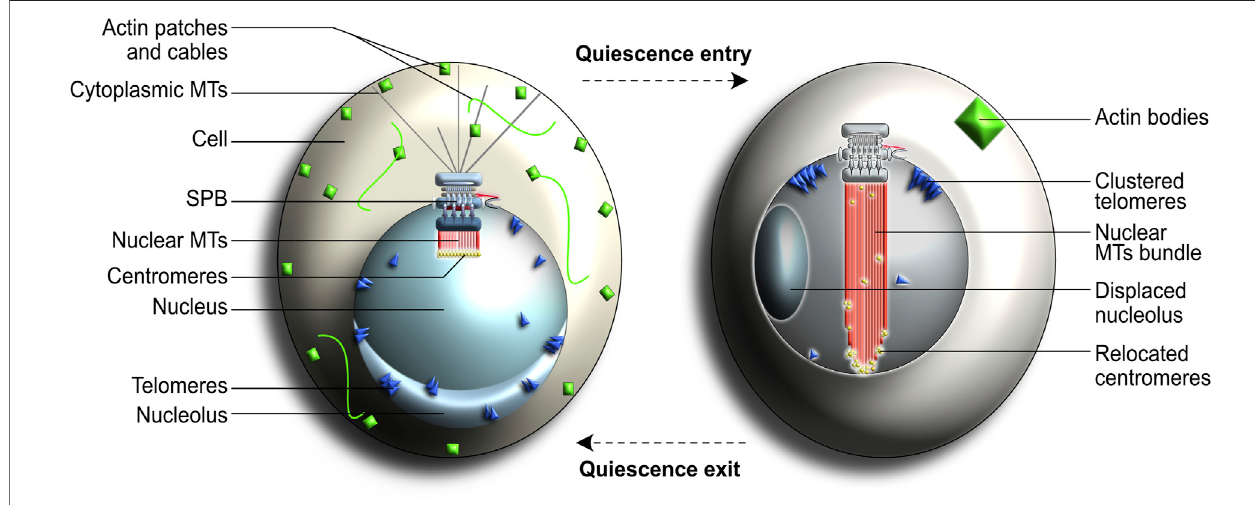
FIGURE 7 | Cellular changes associated with the quiescent state in yeast. These changes include the disappearance of cytoplasmic microtubules (MTs) and formation of a nuclear bundle of MTs (nMTs) that spans the entire nucleus. Centromeres (shown in yellow) normally cluster together at the end of nuclear MTs in interphase cells (left) but get redistributed along the length of the newly formed nMT bundle in quiescent cells (right). Chromosome arms are omitted from this fi gure to simplify the representation. See text for more details.